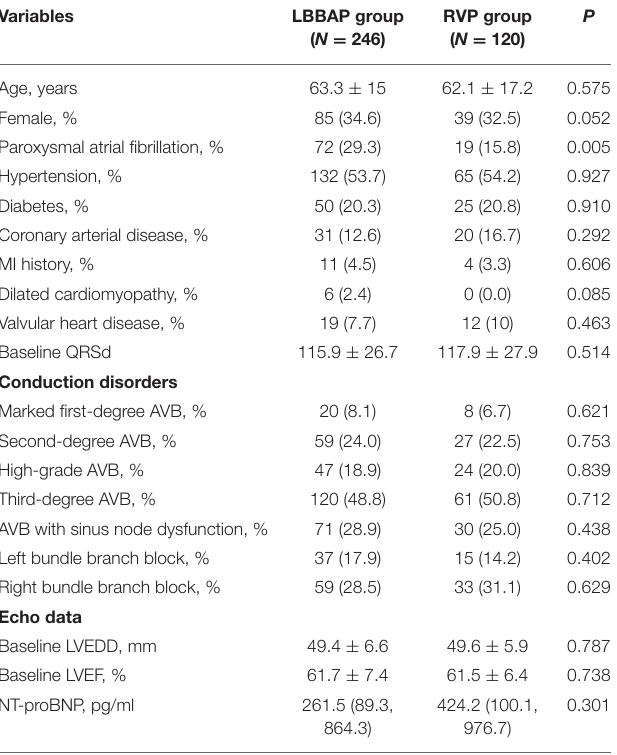
TABLE 1 | Baseline characteristics of AVB patients.